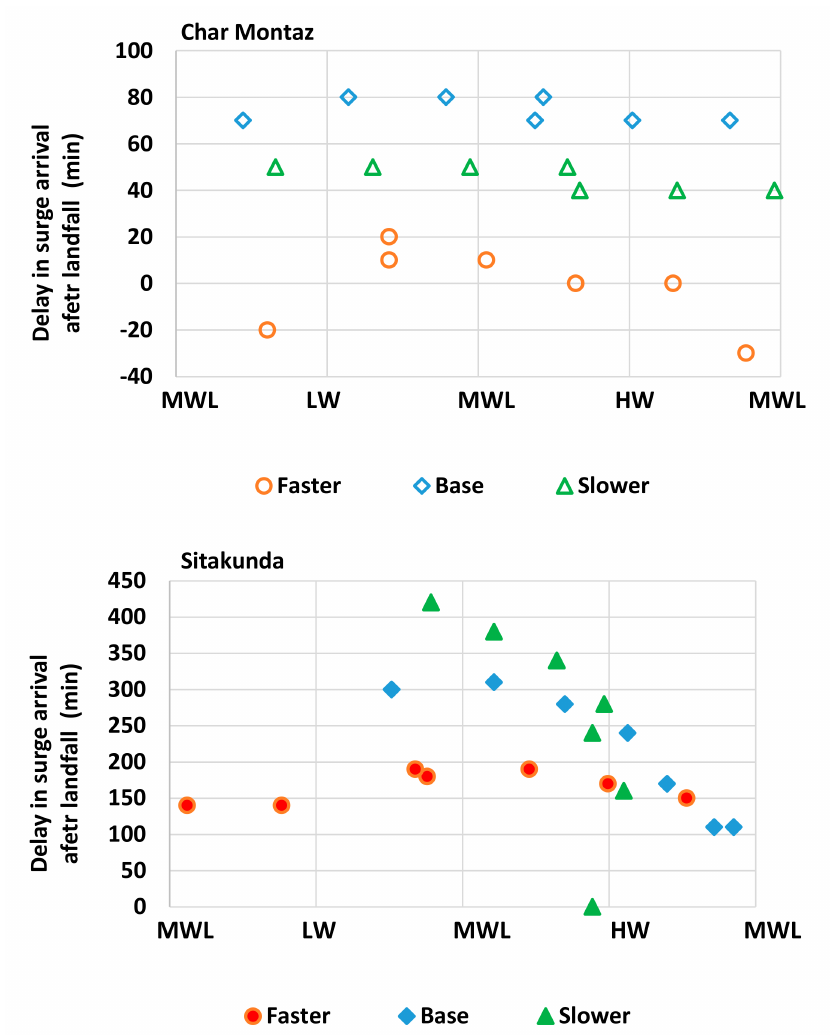
Figure 7. Delay in maximum surge arrival (in minutes) at different tidal phases for three track speed cases during Cyclone Sidr at Char Montaz ( upper panel ) and at Sitakunda ( lower panel